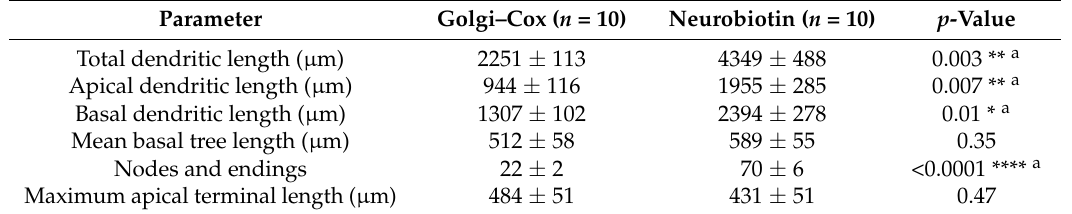
Table 1. General Morphology.